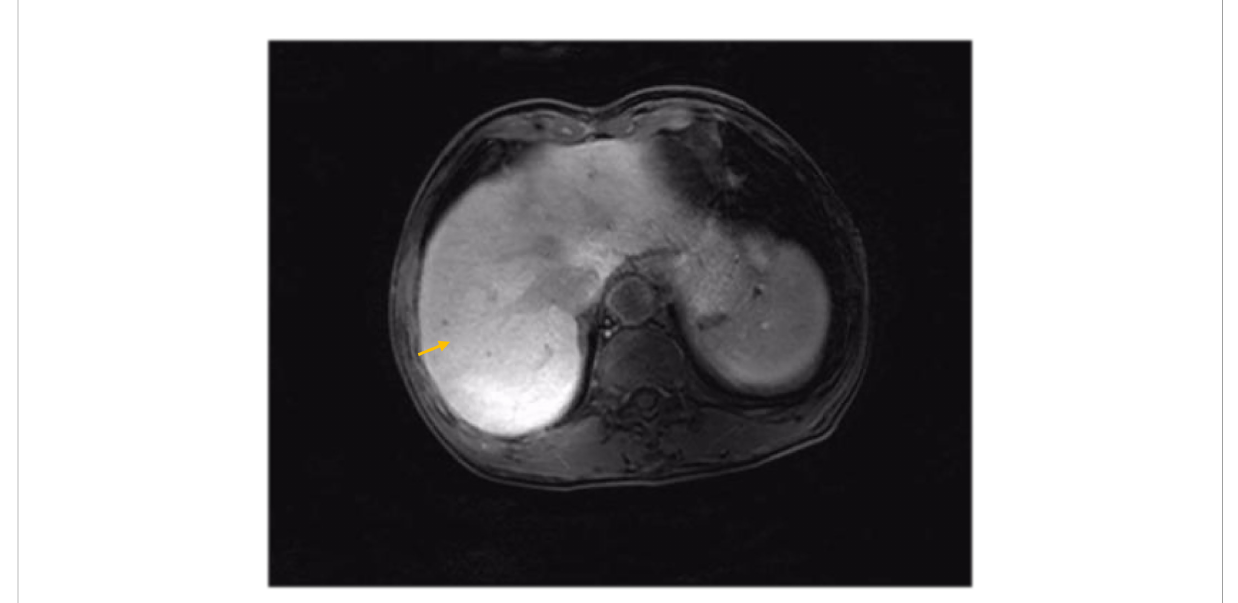
FIGURE 6 MRI fi ndings during the patient ’ s last chemotherapy session (liver metastases